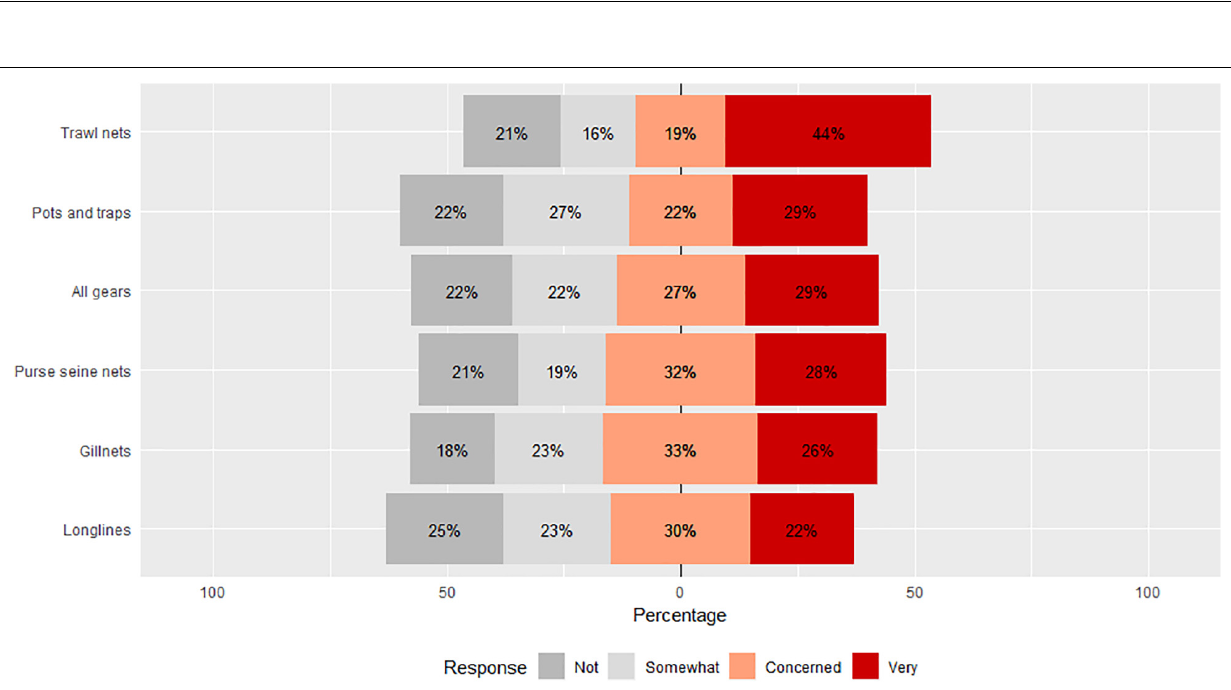
FIGURE 4 | Levels of concern around ALDFG reported by fishers across all gear types and countries, combined; and for specific gear types (gillnets, purse seine nets, trawl nets, longlines, and pots and traps) across all countries. Low levels of concern are presented on the left side of the figure in dark to light grays, leading to higher concern levels as the reader moves right and the colors warm from orange to salmon to red. Reading left to right, levels of concern reported by fishers were ranked as “Not at all concerned,” “Concerned,” “Somewhat concerned,” and “Very concerned.” Total percentages are reported for each response and presented over the associated color